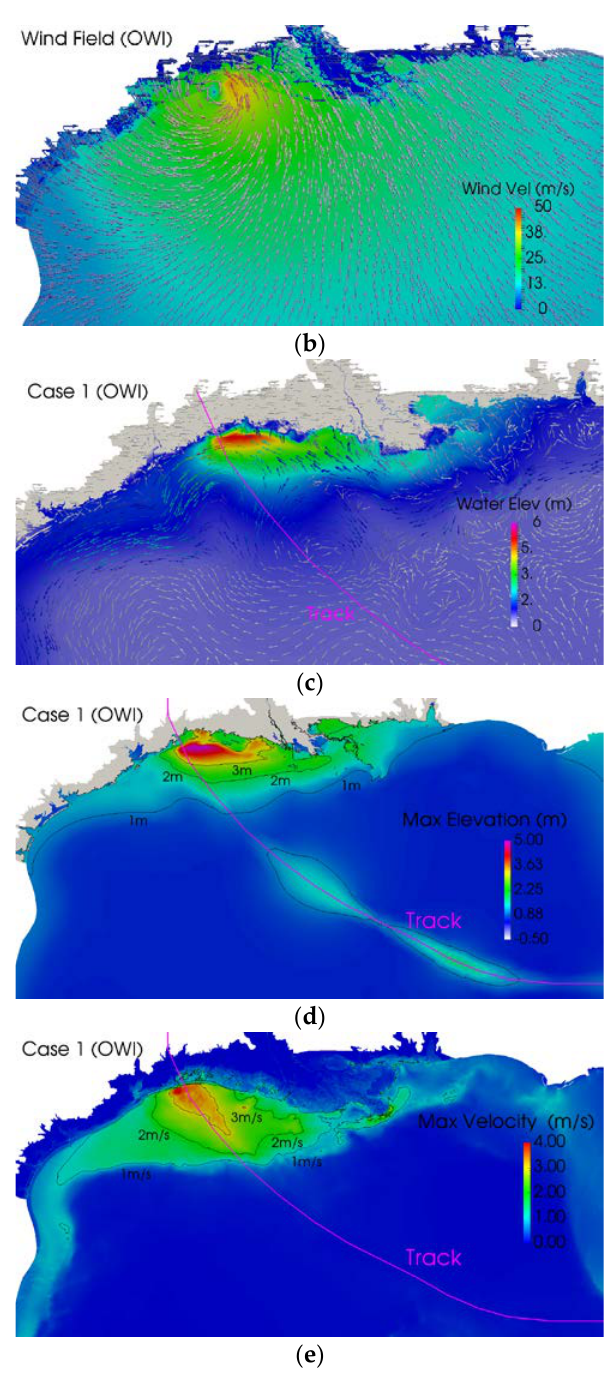
Figure 3. Case 1 wind field and storm surge hindcast results, ( a ) maximum wind track using OWI model; ( b ) Wind vector at 8:30 AM, 24 September 2005; ( c ) Water elevation and velocity vector at 8:30 AM, 24 September 2005; ( d ) maximum water elevation; and ( e ) maximum water